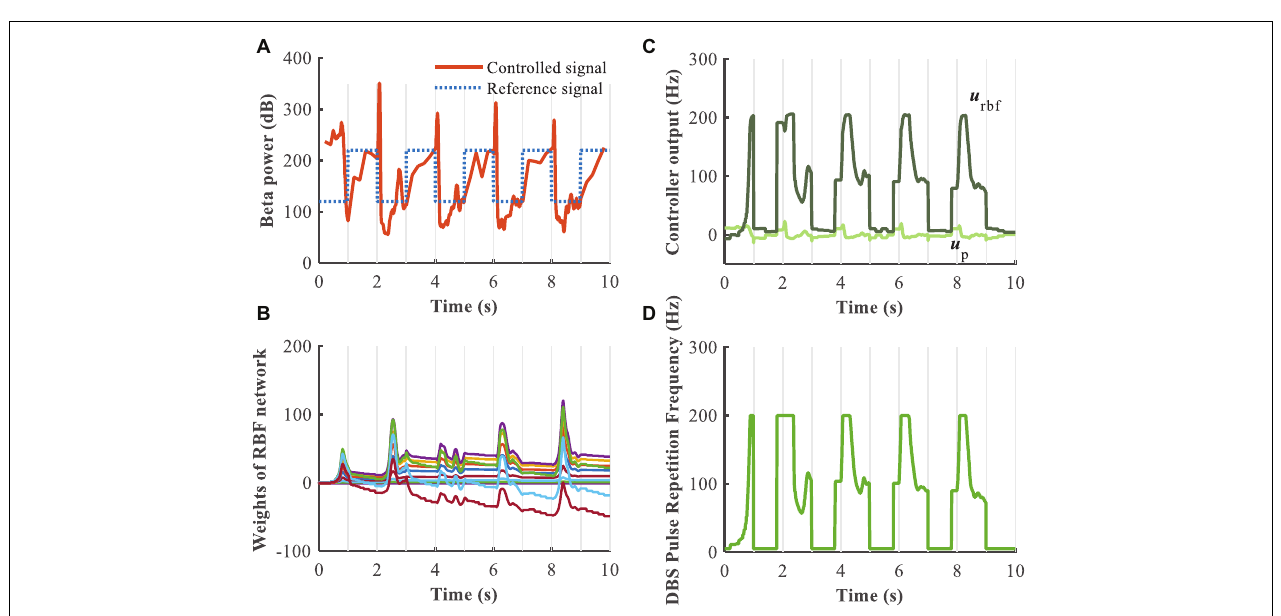
FIGURE 11 | Robustness analysis of the RBF controller during dynamic changes in the reference beta power ( k p = 0 . 1 ) . (A) Dynamic change of the reference beta power is characterized by the blue dotted line. The RBF-controller modulated beta power is depicted in the bottom panel. Panel (B) shows the evolution of real-time updated weights of the RBF network, (C) plots the trend of P controller and RBF controller, and (D) generates the DBS pulse repetition frequency. Here, the stimulation amplitude is set to 300 µ A / cm 2 and the pulse duration is set to 0.3